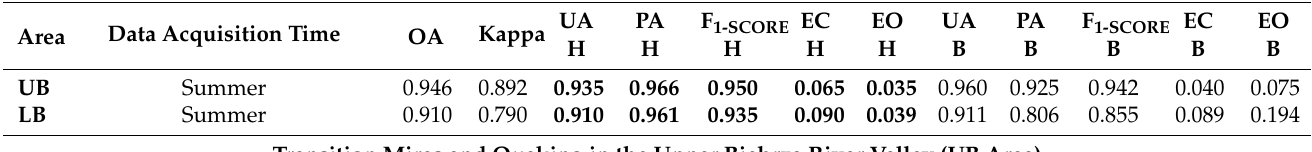
Table 5. The best classification results obtained using the Random Forest multi-classification approach with Recursive Feature Elimination with Cross-Validation for alkaline fens in the UB and LB areas and transition mires and quaking bogs in the UB and JF